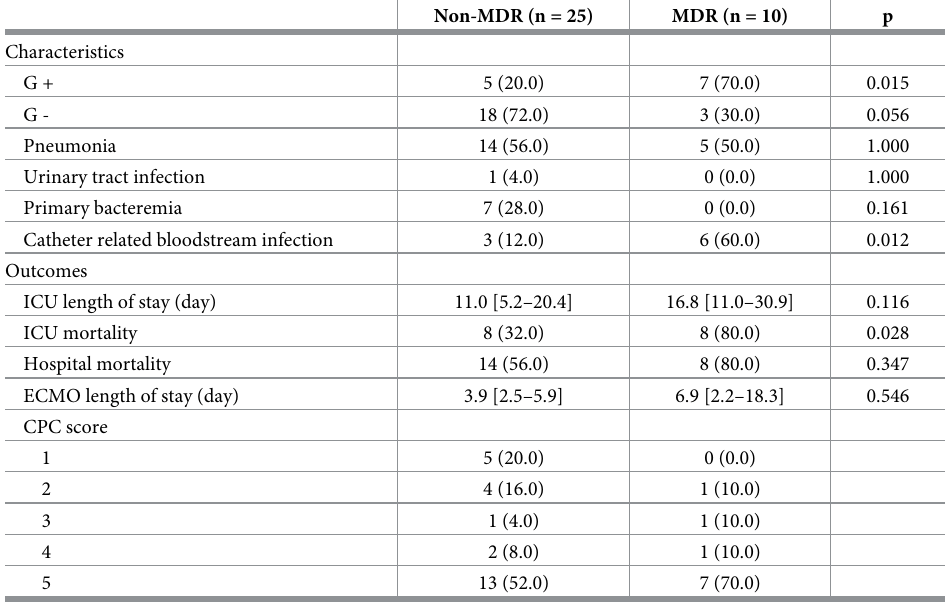
Table 3. Characteristics and outcomes according to the presence of MDR in patients with nosocomial infection.